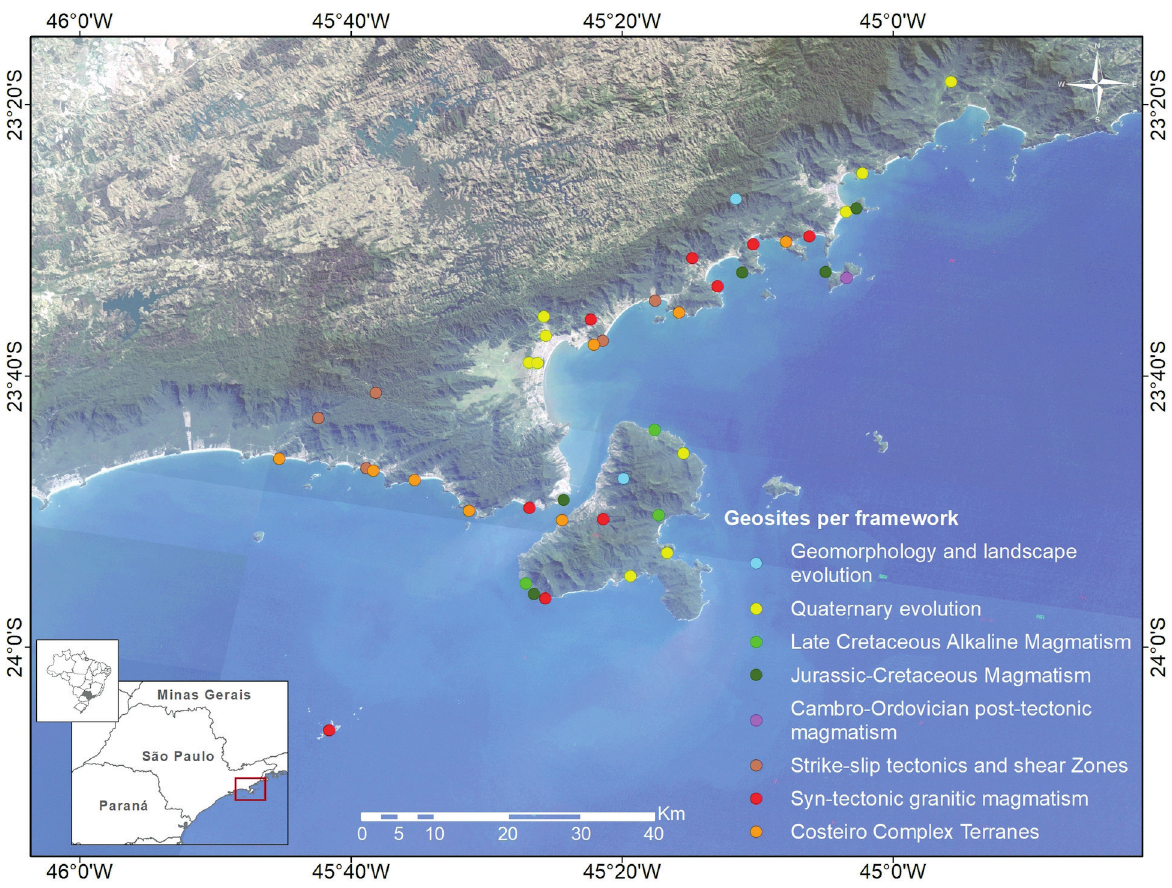
Figure 1 - Map of the northern coast of São Paulo State showing the location of the geosites according to each geological